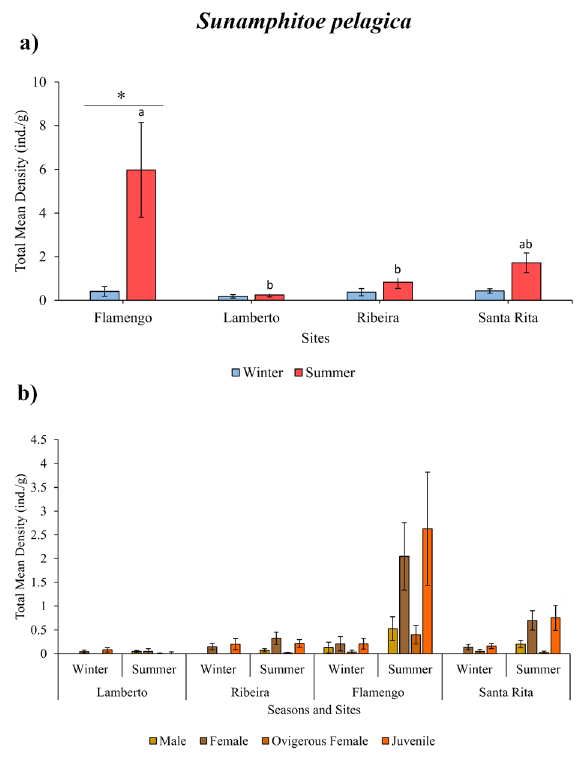
Figure 3. ( a ) Total mean density (ind./g) of Sunamphitoe pelagica at each beach in winter and summer; ( b ) total mean density (ind./g) of males, females, ovigerous females and juveniles at each beach in winter and summer (± standard error). Bars with the same letter indicate no significant differences. Asterisk represents significant difference